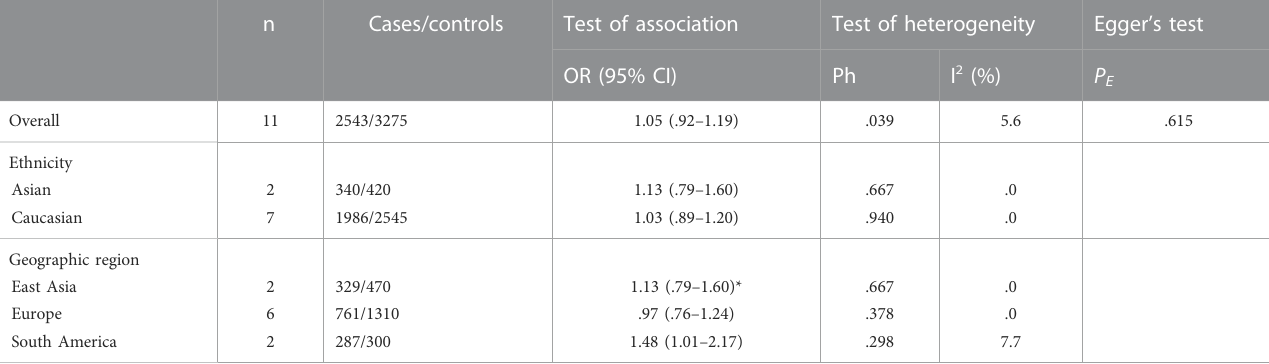
TABLE 7 Pooled estimates of the association of GSTT1 polymorphism with risk of ovarian cancer.